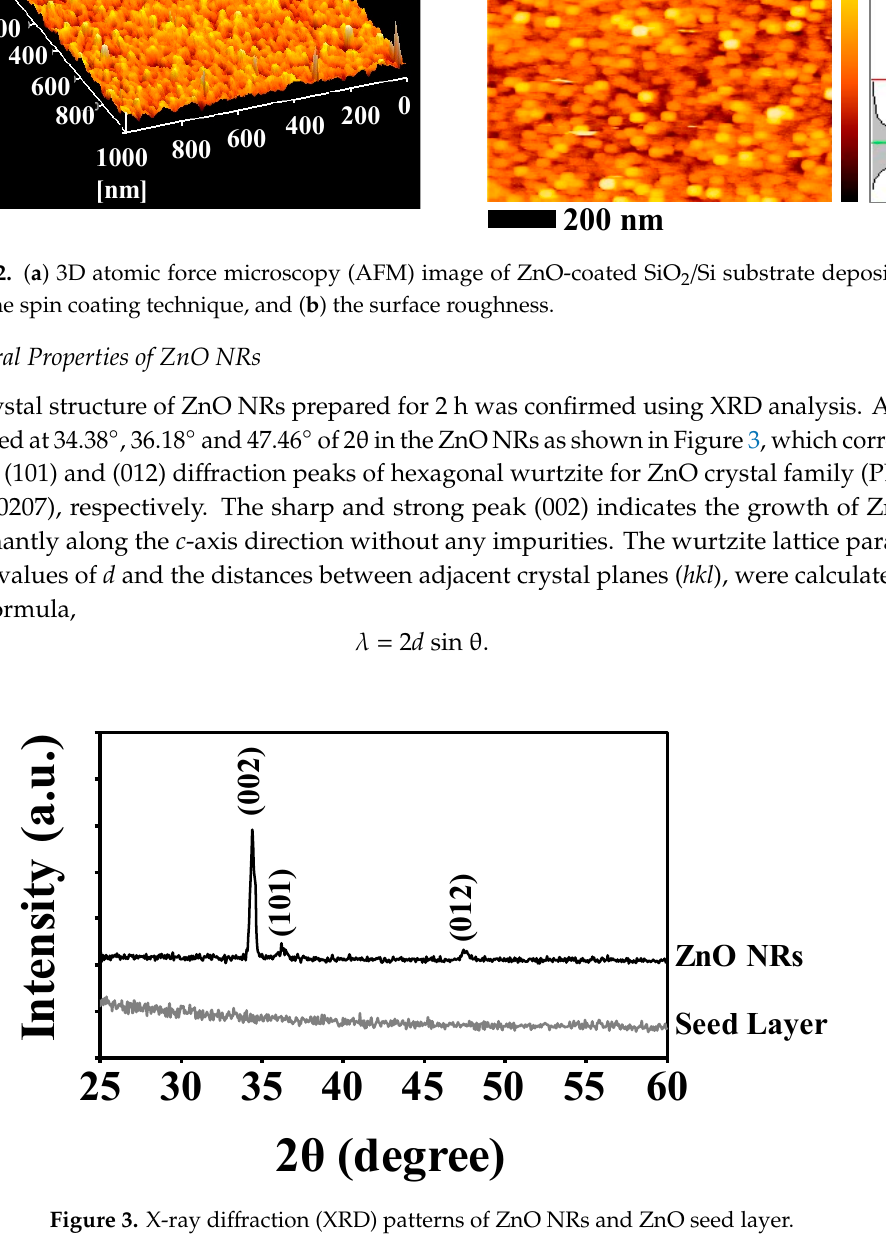
Figure 4. Transmission electron microscopy (TEM) images of ZnO NRs synthesized for 2 h at ( a ) low magnification TEM image, ( b ) high magnification TEM image, and ( c ) the selected area of electron diffraction (SAED) pattern, obtained at 120 kV.